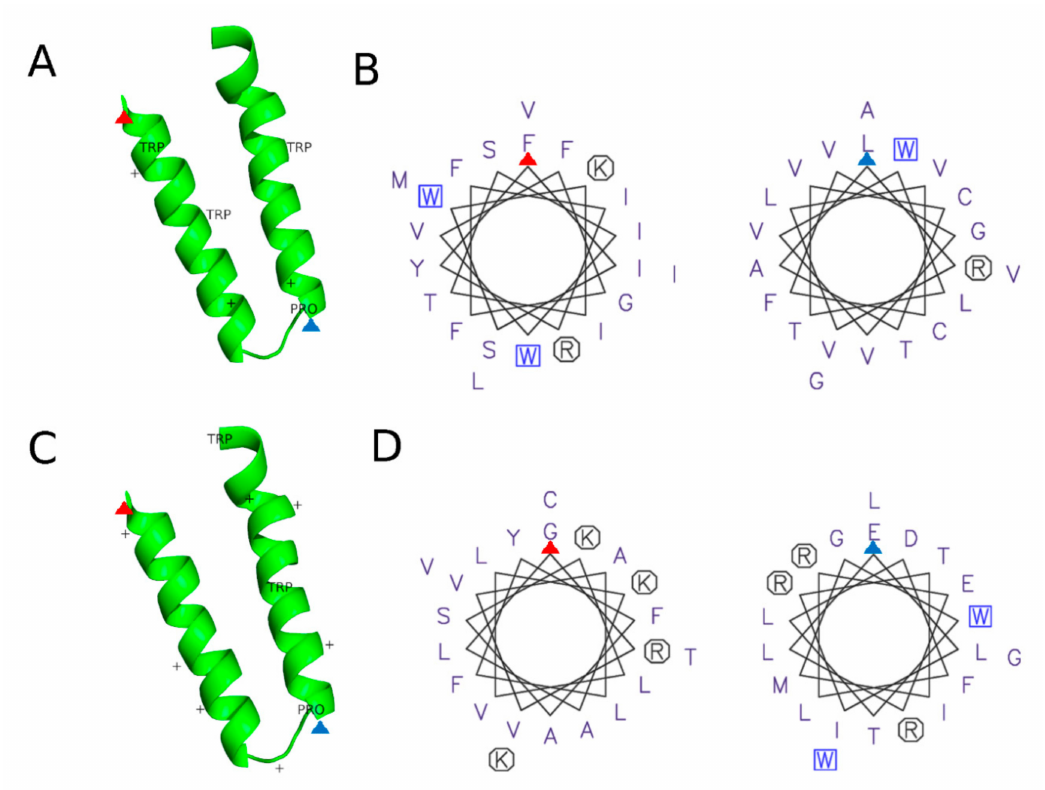
Figure 2. ( A ) Structure prediction of LiveDrop is based on the residues 163–206 of Drosophila GPAT4 (isoform B) [64] mounted on the v-shaped hairpin motif of the BAX protein [9] so that proline residues are aligned (residues 108–151; coordinates from PDB 1f16, chain A). Labels show proline, positively charged residues (H, K, R) and tryptophans. In ( B ) Helical wheel plots for the N-terminal helix (residues 163–184) and C-terminal helix (residues 186–206) of LiveDrop are presented. Positively charged residues are shown in octagons, tryptophans in squares (EMBOSS pepwheel). The first amino acid in helix one is marked by a red triangle, the first amino acid in helix 2 is marked by a blue triangle. Amino acids 1–18 are located in the inner circle, amino acid 19 and the following in the outer circle. ( C ) shows a structure of the v-shaped hairpin motif of the BAX protein. Labels as in ( A ). In ( D ) Helical wheel plots for the N-terminal helix (residues 108-129) and C-terminal helix (residues 131–151) of the BAX hairpin are displayed. Symbols as in ( B